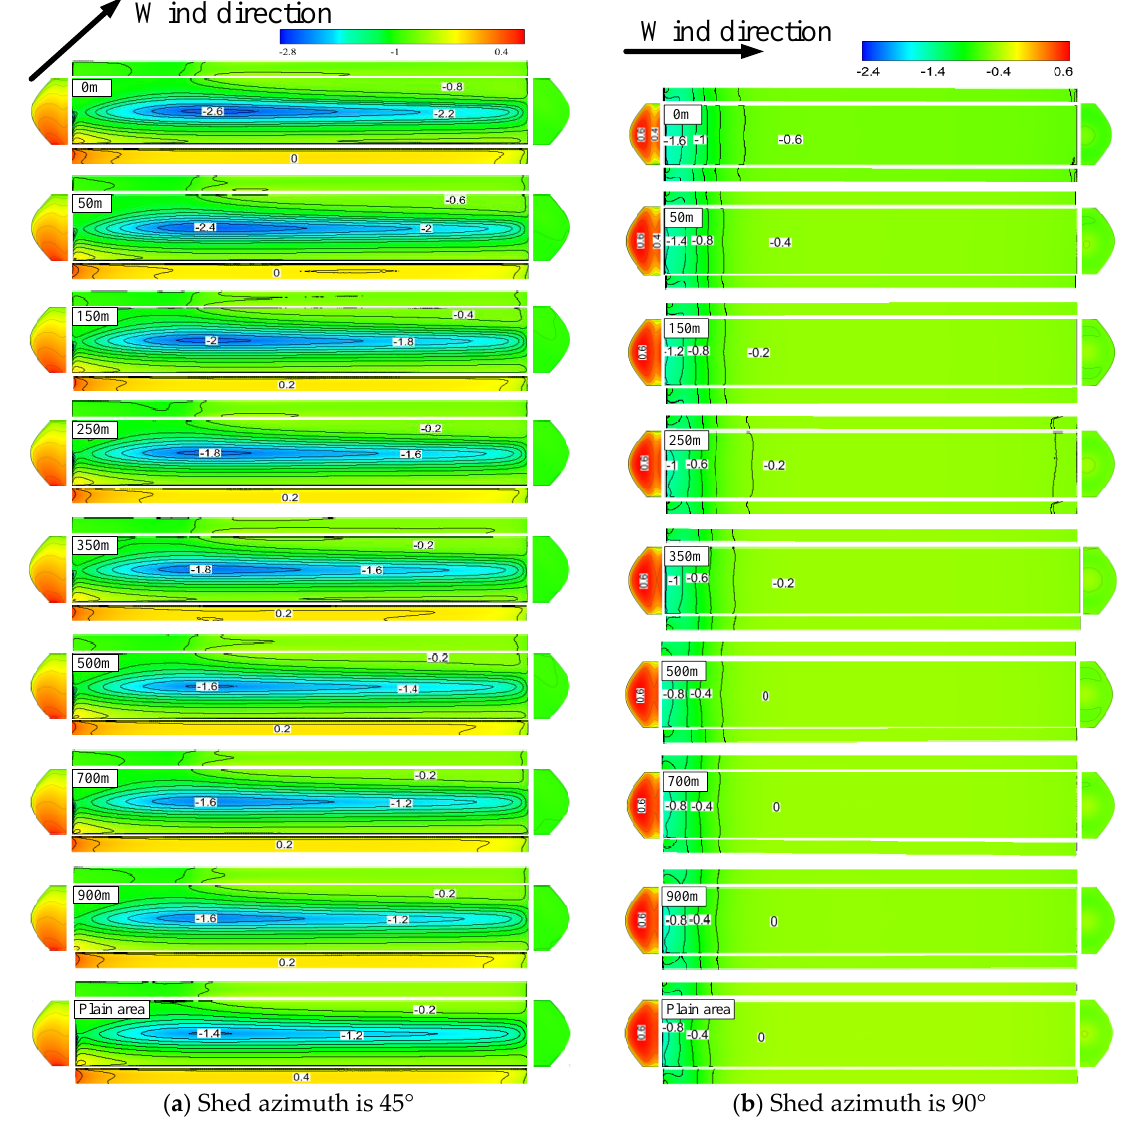
Figure 13. Wind pressure distribution of shed with d = 0, 50, 150, 250, 350, 500, 700, and 900 m and in a plain area. Table 6. Distribution coefficient of wind pressure on each shed surface when the shed azimuth angle in the plain area is 45 ◦ .